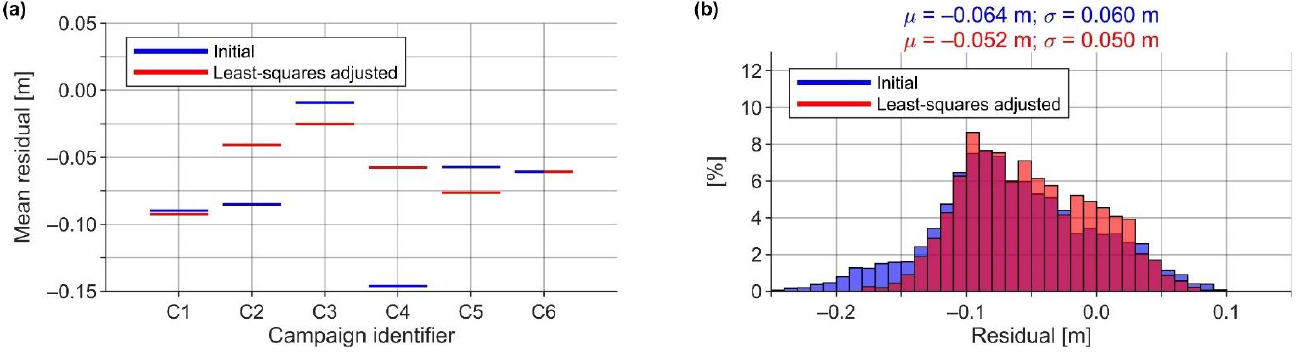
Figure 17. The final filtered, corrected, and least-squares adjusted residuals 𝑟 𝐶𝑜𝑀𝐹+𝐶+𝐴 .